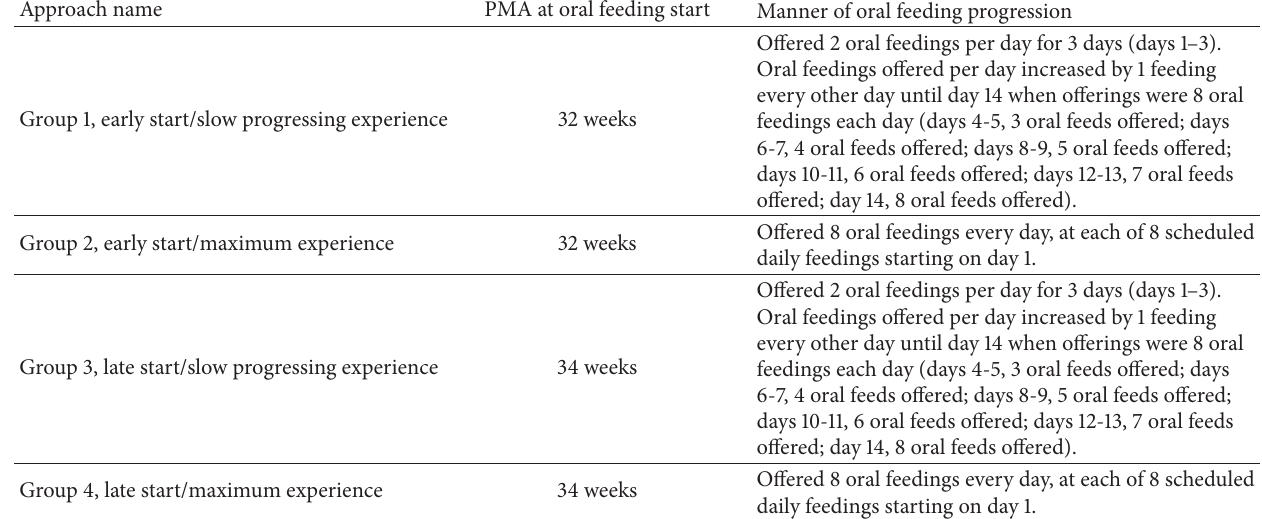
Table 1: Description of four feeding